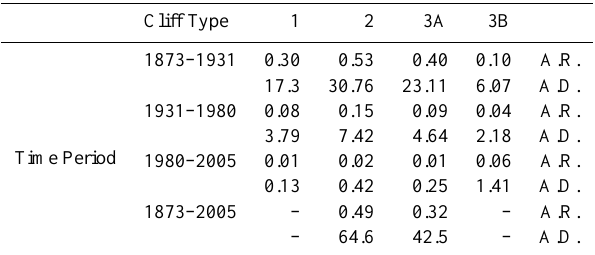
Table 4. Average retreat rates and average distances for different time periods, with respect to the Cliff’s